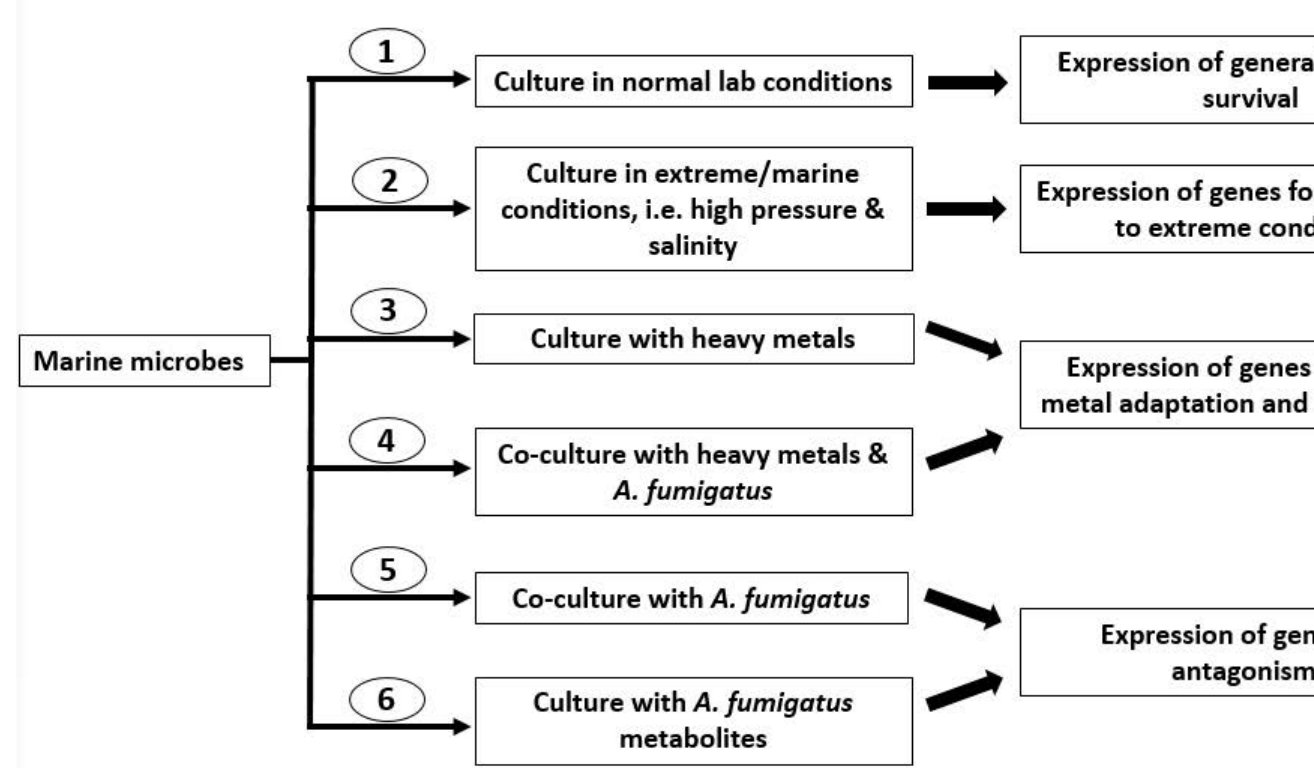
Figure 6. Suggested culture approaches to increase the discovery of antifungal bioactive